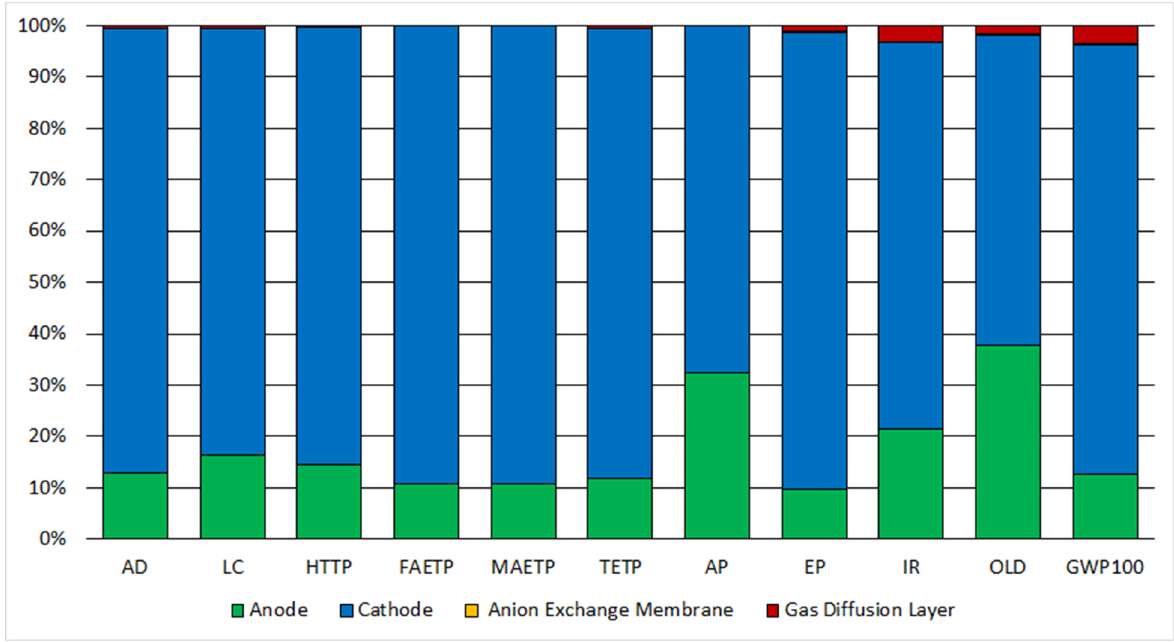
Figure 7. Impact of AEMFC components on the midpoint impact categories. AD = Abioti Depletion (elem., reverse base); LC = Land Competition; HTP = Human Toxicity Potential 100a; FAETP = Freshwater Aquatic Eco Toxicity Potential 100a; MAETP = Marine Aquatic Eco Toxicity Potential 100a; TETP = Terrestrial Eco Toxicity Potential 100a; AP = Acidification Potential (fate not incl.); EP = Eutrophication Potential (incl. fate); IR = Ionising Radiation; OLD = Ozone Layer Depletion (incl. NMVOC av.); GWP = Global Warming Potential 100a (incl. NMVOC av.).